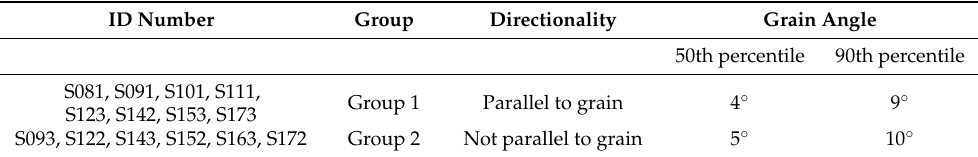
Table 1. ID number of the samplings, their classification into the group (1 or 2) based on the directionality in the beam slices.